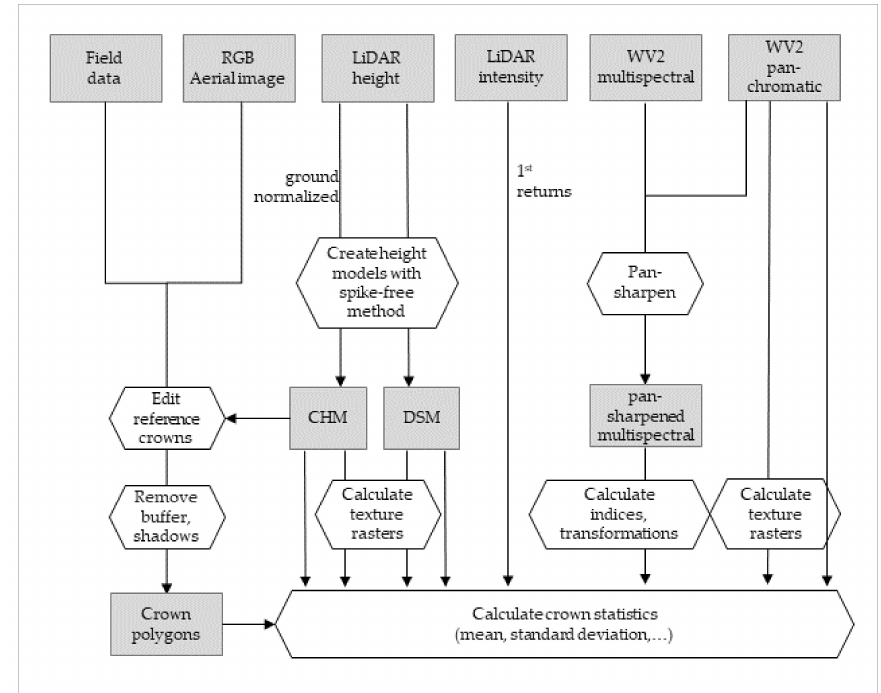
Figure 6. Workflow diagram for the attribute